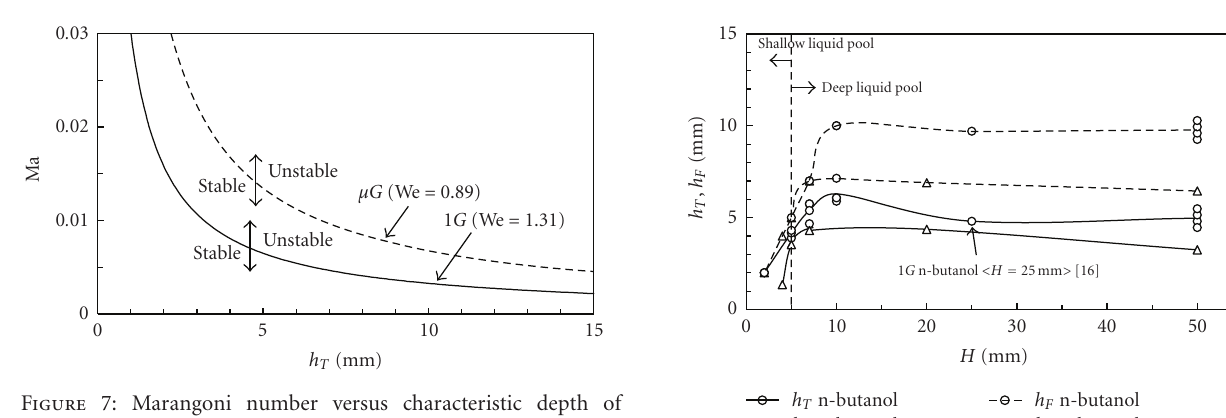
Figure 7: Marangoni number versus characteristic depth of subsurface layer circulation.